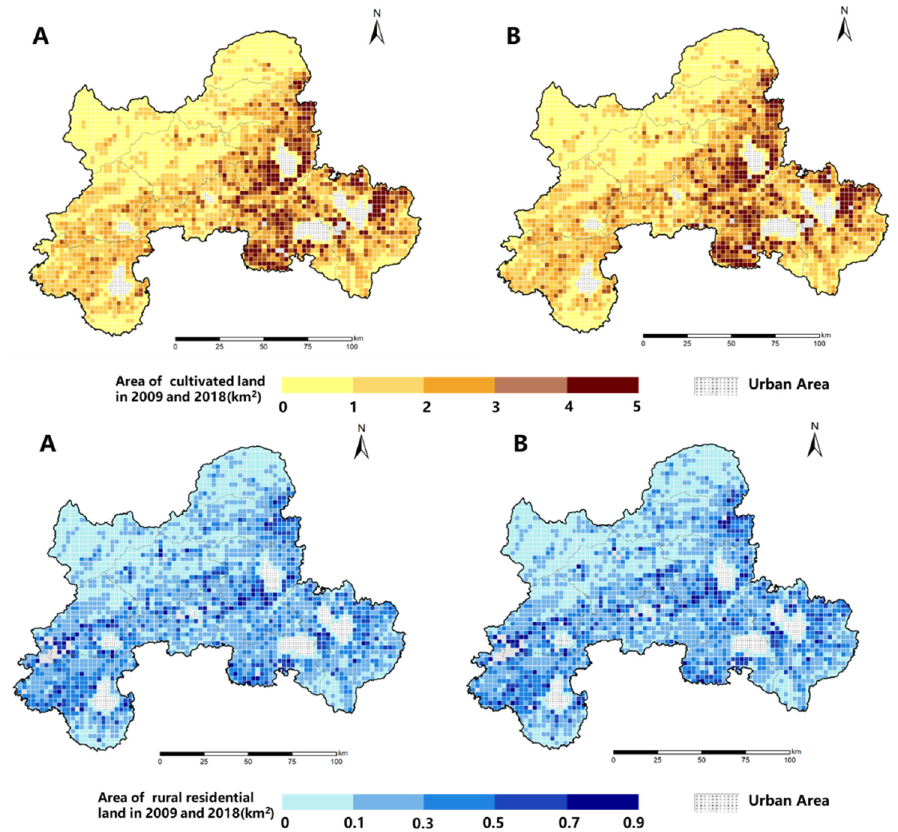
Figure 3. Area of cultivated land ( Top ) and rural residential land ( Below ) within 2.5 km grid ( A ) in 2009, ( B ) in 2018.